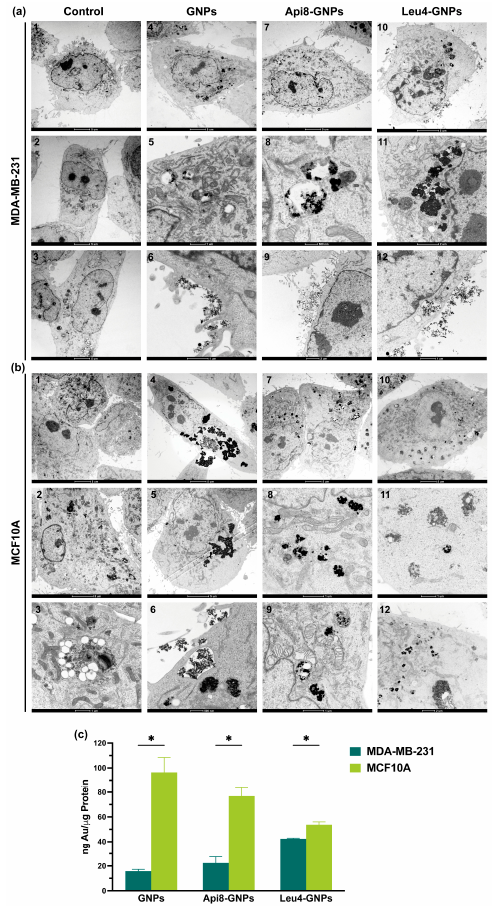
Figure 6. TEM images acquired at different magnifications of MDA-MB-231 ( a ) and MCF-10A ( b ) cells incubated for 24 h with free GNPs, Api8-GNPs, or Leu4-NPs. Scale bars: 5 µm, images ( a1 )– ( a4 ), ( a7 ), ( a10 ), ( b1 ), ( b2 ), ( b4 ), ( b5 ), ( b7 ), ( b10 ); 2 µm, images ( a9 ), ( a11 ), ( b12 ); 1 µm, images ( a5 ), ( a6 ), ( a12 ), ( b3 ), ( b8 ), ( b9 ), ( b11 ); 500 nm, images ( a8 ), ( b6 ). ( c ) Uptake of the GNP formulations measured by atomic absorption spectrometry (AAS). The quantity of internalized GNPs inside samples is reported as ng of gold and expressed with respect to the µ g of protein content. Data are expressed as mean percentage ± SD of at least two independent experiments, carried out in triplicate. *: p < 0.001, significantly different from MCF-10A cells ( t